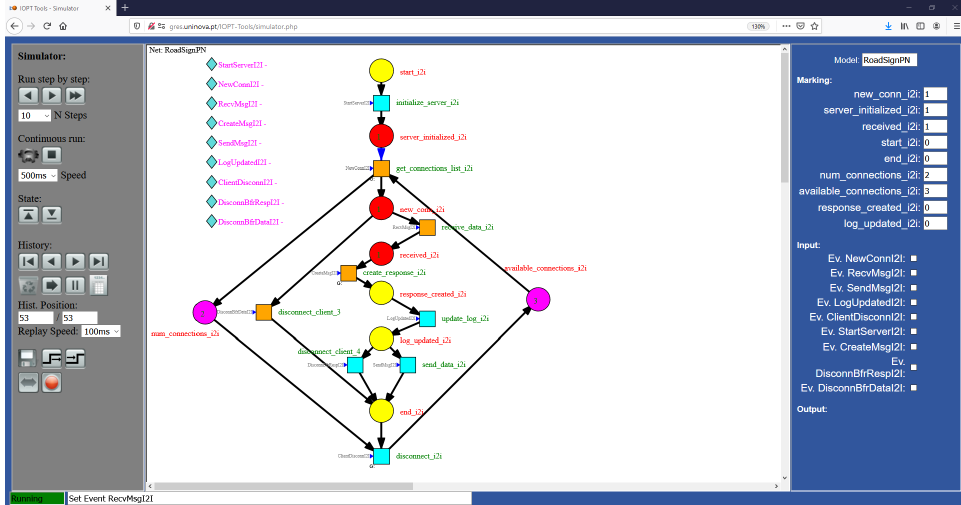
Figure 5. The IOPT edition tool with the model of the controller of the NOVA-WiFi-Client Provider (NWCP) module.